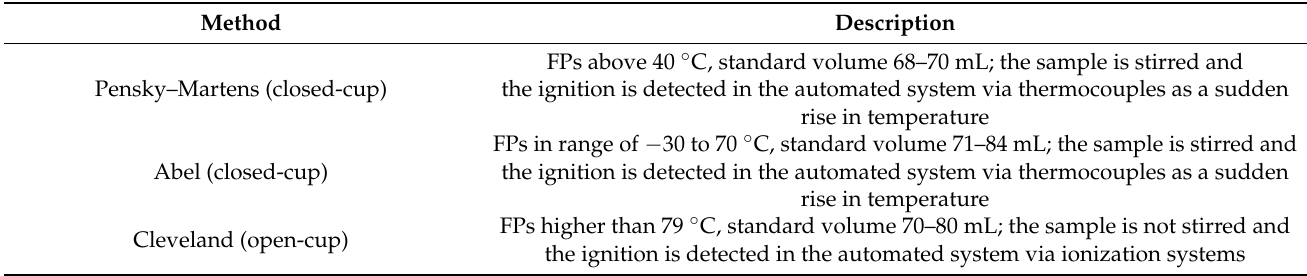
Table 6. Standardized methods for FS